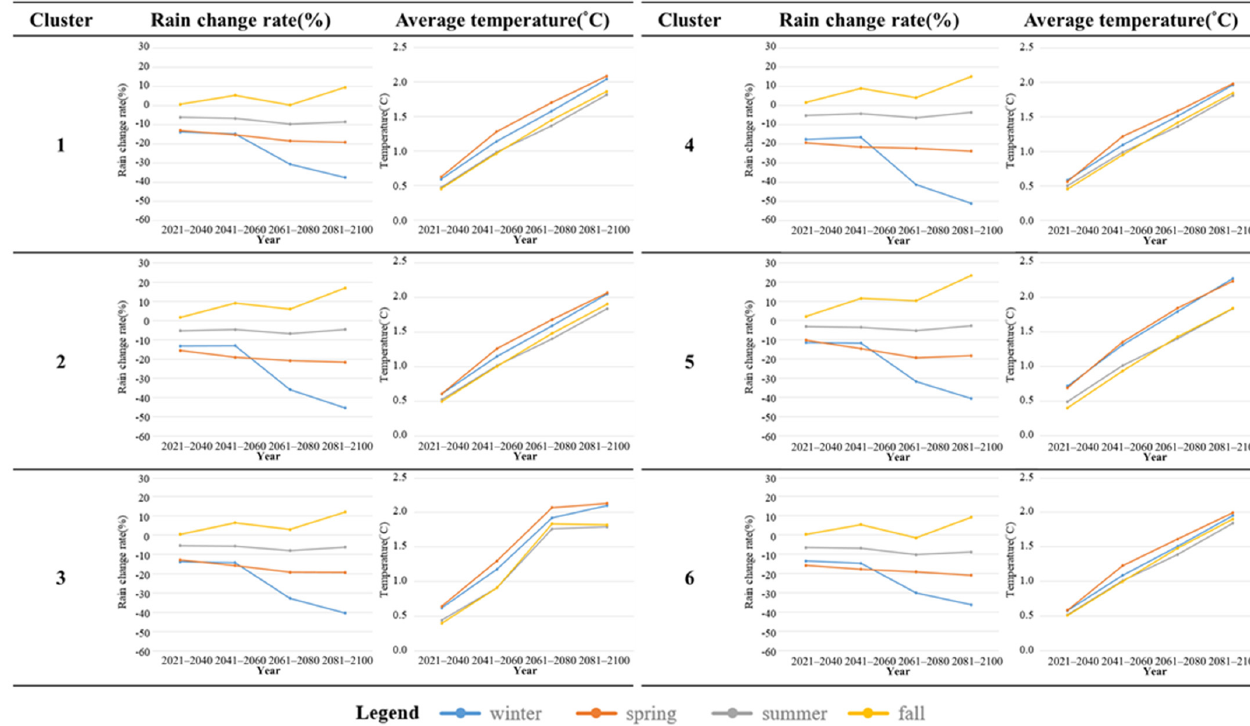
Figure 4. Average values of rain change rate and temperature data for the four scenarios (RCP2.6, RCP4.5, RCP6.0, and RCP